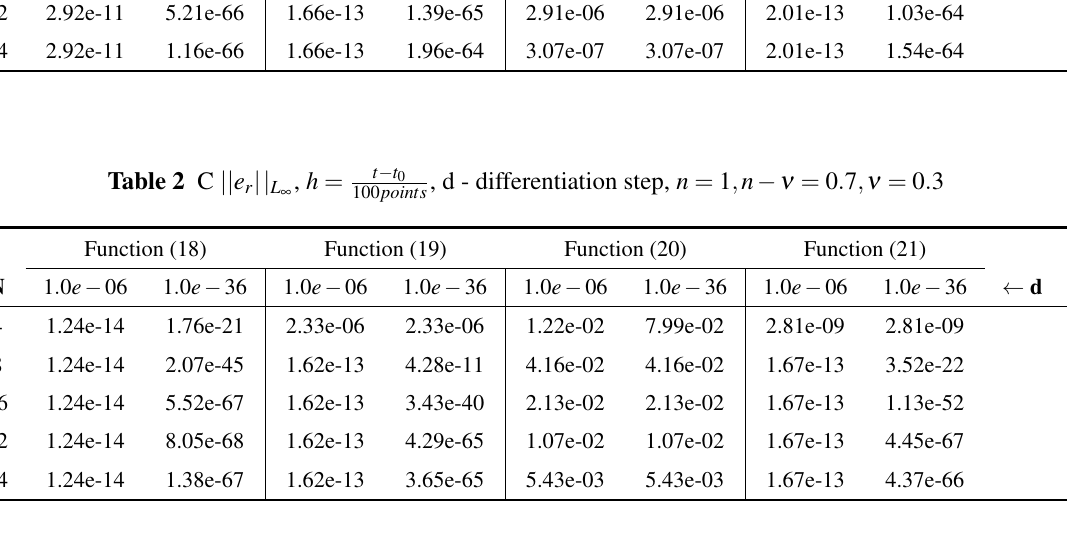
Table 3 RL || e r || L